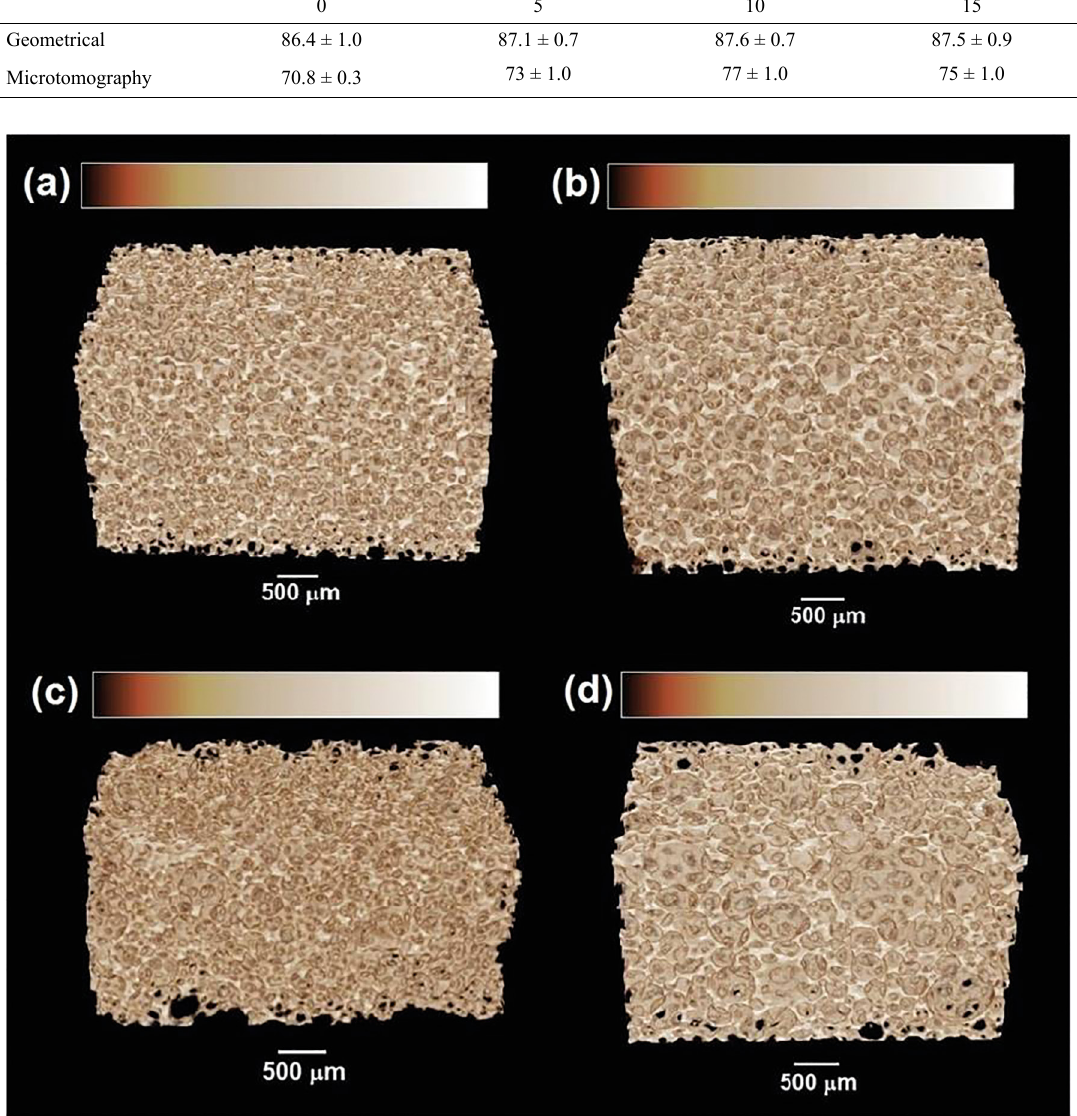
O – 95/5; (c) β-TCP/Al 2 3